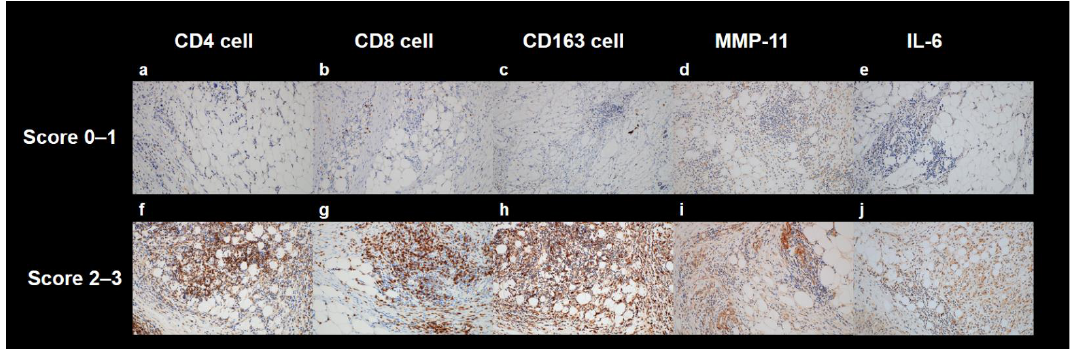
Figure 3. Representative images of immunohistochemical analyses of the perigastric AT. Immuno- histochemical staining of CD4 ( a , f ), CD8 ( b , g ), CD163 ( c , h ), MMP-11 ( d , i ), and IL-6 ( e , j ). Examples of a score range of 0 – 1 are shown in ( a – e ), and examples of a score range of 2 – 3 area shown in ( f ) – ( j ). The magnifications of all images were